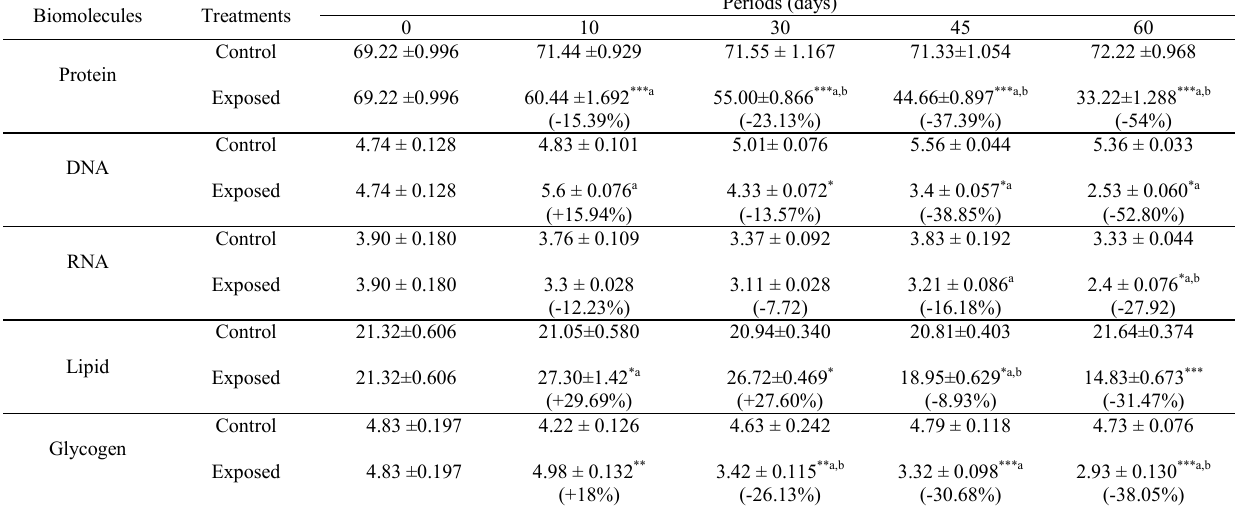
Table 1. Fluctuations in different biomolecules in the skin of Clarias batrachus at different period of exposure to 1mg/L of sodium arsenite. Protein, DNA, RNA, lipid, and glycogen were expressed in mg/gm wet wt of tissue. Data are shown as mean ± SEM (n = 9). (%) Denote changes over respective controls. Two way ANOVA followed by Dunnett’s t -test. The criterion for significance differences set at ( * ) p <0.05, ( ** ) p <0.01 and ( *** ) p <0.001 with respective control. ( a ) Indicates when exposed groups were compared with 0 day controls and ( b ), when exposed groups were compared with previous exposed